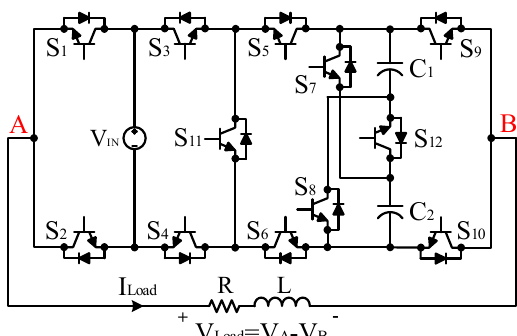
Figure 1. The proposed 9 L topology.